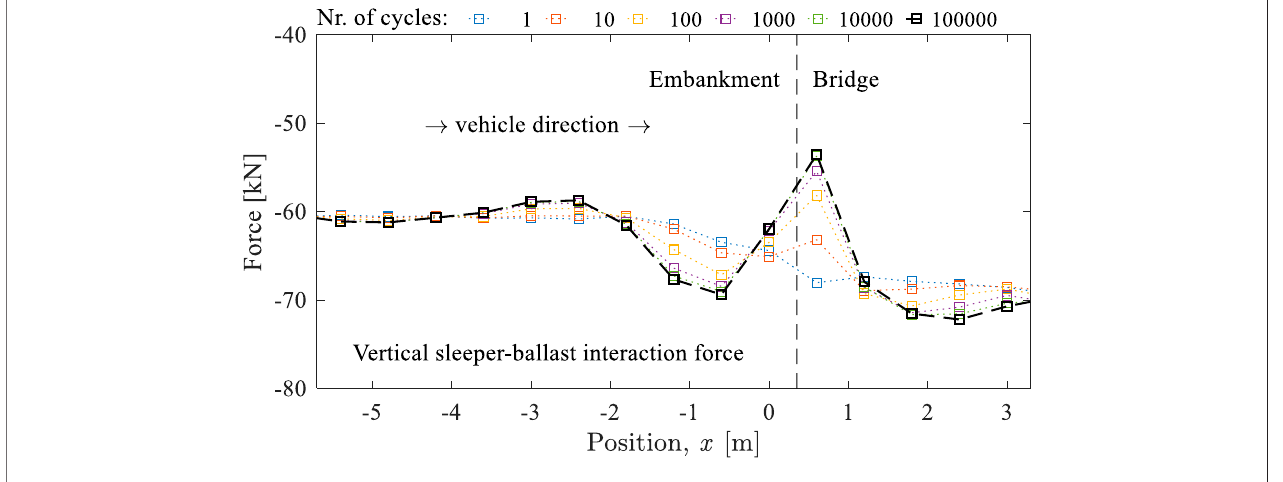
FIGURE 10 | Evolution of peak vertical sleeper-ballast interaction forces with